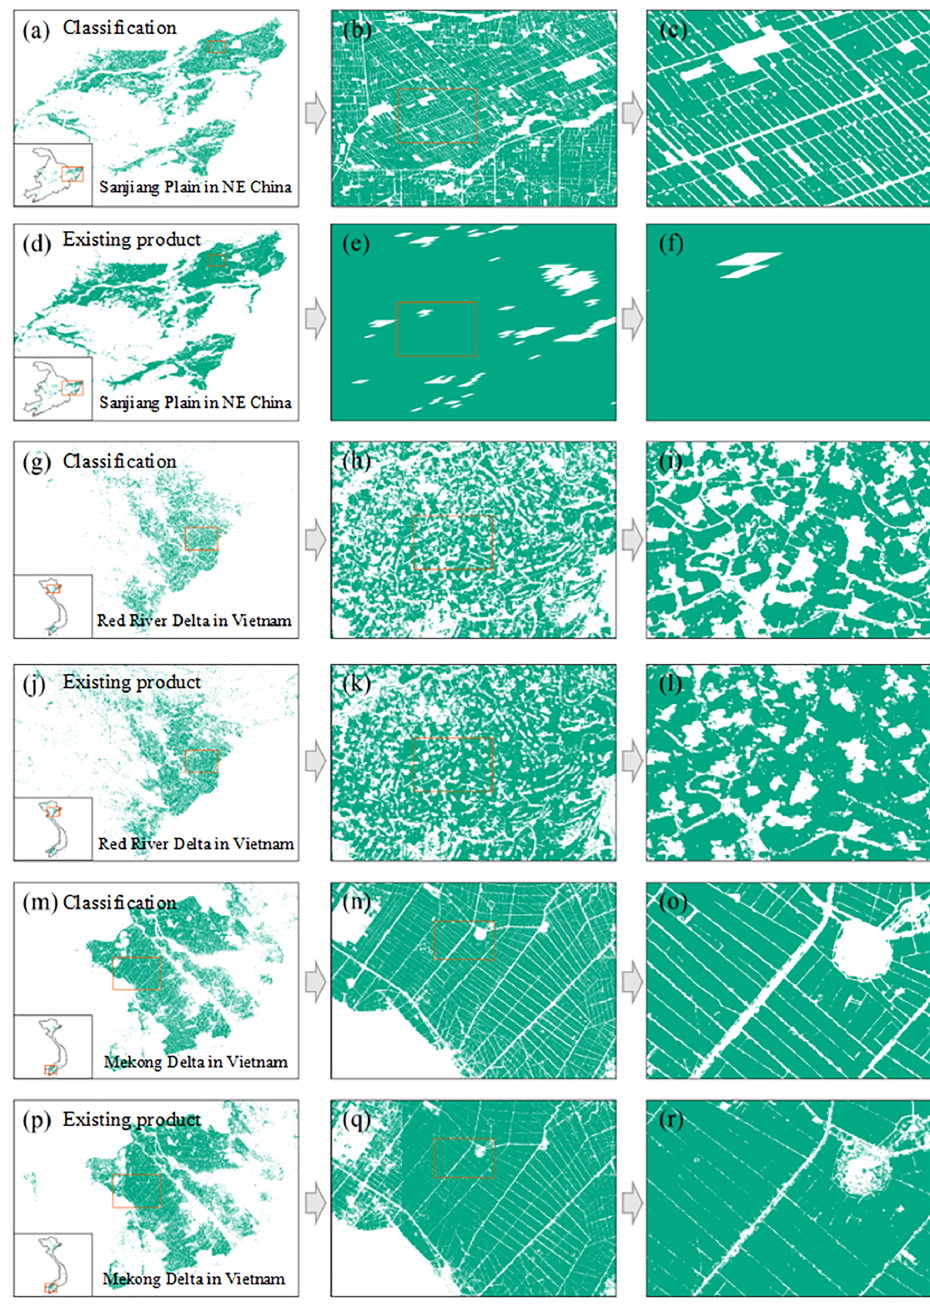
Figure 9. Visual comparison of our paddy rice maps and existing products in typical regions in 2017: (a–c, g–i, m–o) classification using our method. The example data for (a, g, m) can be found at the following link: https://doi.org/10.17632/cnc3tkbwcm.1 (Han et al., 2021b); see example 01–03. (d–f) MODIS-based paddy rice fields and (j–l, p–r) JAXA-derived rice fields are also